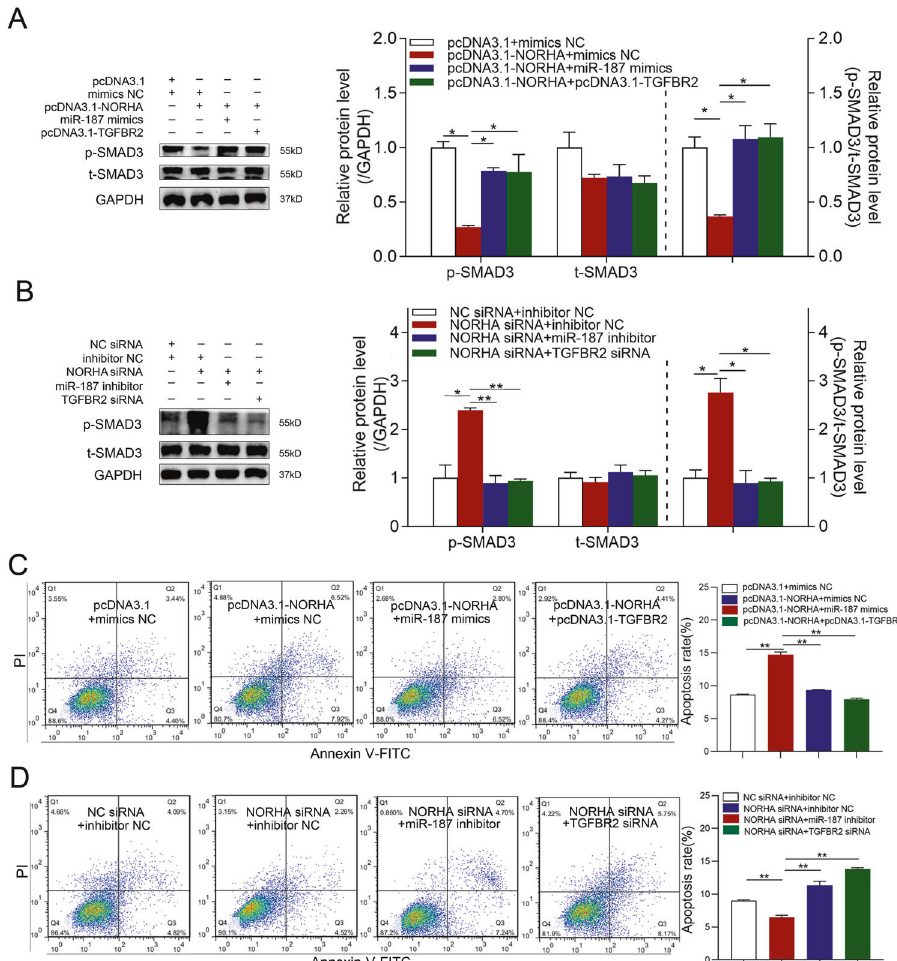
Fig. 5 NORHA regulates TGF- β signaling and GC apoptosis by a miR-187/TGFBR2 axis. A , B Western blotting was used to detect p-SMAD3 and t-SMAD3 protein levels after co-transfection with pcDNA3.1-NORHA and miR-187 mimics or pcDNA3.1-NORHA and pcDNA-TGFBR2 ( A ), or NORHA-siRNA and miR-187 inhibitor or NORHA-siRNA and TGFBR2-siRNA ( B ). C , D FACS analysis was used to detect the apoptosis rate of GCs after co-treatment with pcDNA3.1-NORHA and miR-187 mimics or pc3.1DNA-NORHA and pcDNA3.1-TGFBR2 ( C ), or NORHA-siRNA and miR-187 inhibitor or NORHA-siRNA and TGFBR2-siRNA ( D ). Data are represented as mean ± SEM for three independent experiments. * p < 0.05; ** p <